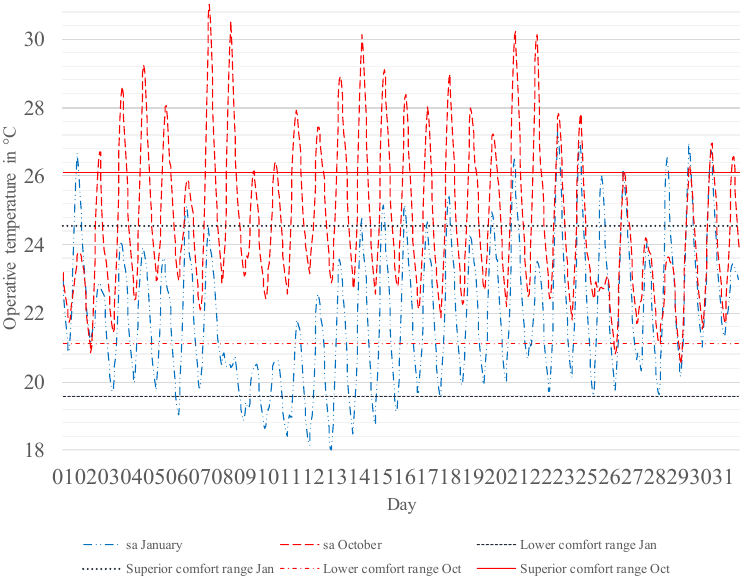
Fig. 13. Selective algorithm Season